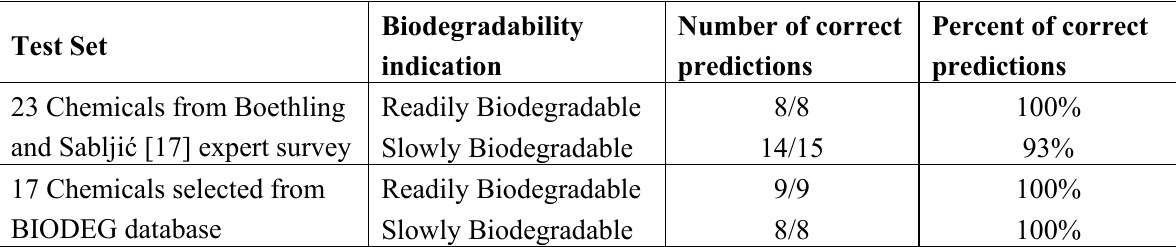
Table 6. Results of Rule A when applied to Boethling and Sablji ć [17] expert survey data and data from the BIODEG database